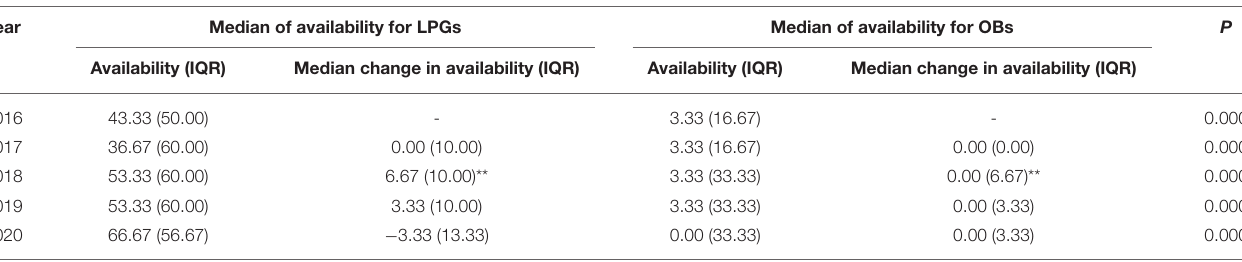
TABLE 3 | Median availability of 45 essential medicines in Nanjing from 2016 to 2020 (%).